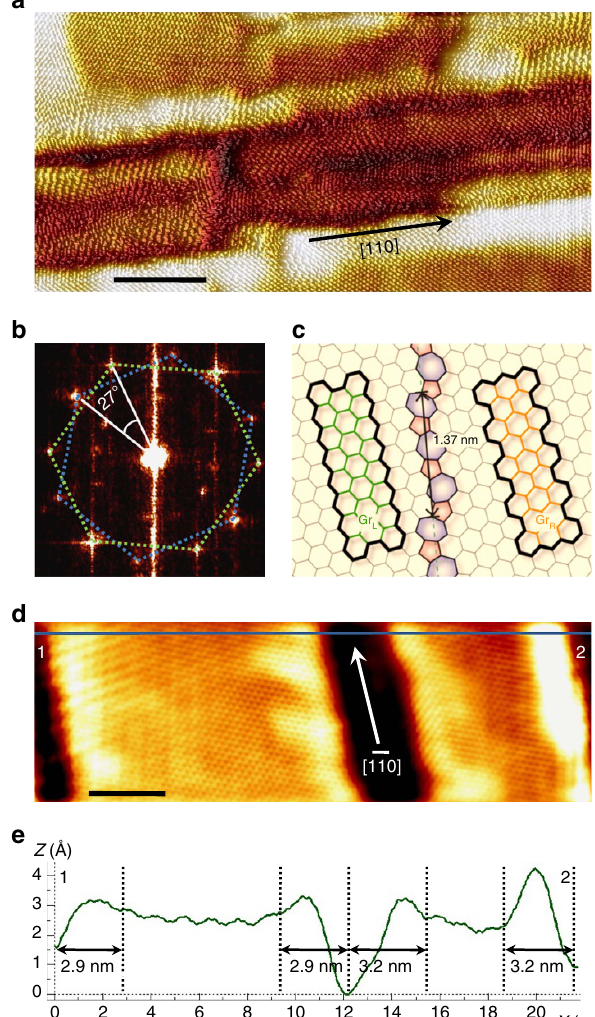
Figure 1 | STM characterization of the trilayer graphene grown on SiC(001). ( a ) Atomically resolved STM image (30 (cid:2) 15nm 2 ) of graphene on a cubic-SiC(001) surface showing the nanodomain structure with domains elongated in the [110] direction. Scale bar, 5nm. ( b ) 2D-Fast Fourier Transform of the image with two 27 (cid:2) -rotated hexagons (dotted green and blue lines) overlaid. ( c ) Schematic drawing of the structure of NB to show zig-zag structure on one side and armchair structure on the other side. ( d ) Atomic-resolution STM image (21.8 (cid:2) 6.9nm 2 ) of two nanodomains with the same lattice orientation elongated along the [1–10] direction. Scale bar, 3nm. ( e ) Cross-section 1–2 from the image shown in d . The sizes of the ripples formed between the domains are indicated for clarity. The STM images were taken at U ¼ 22mV and I ¼ 70pA ( a ) and U ¼ (cid:3) 20mV, I ¼ 100pA ( d